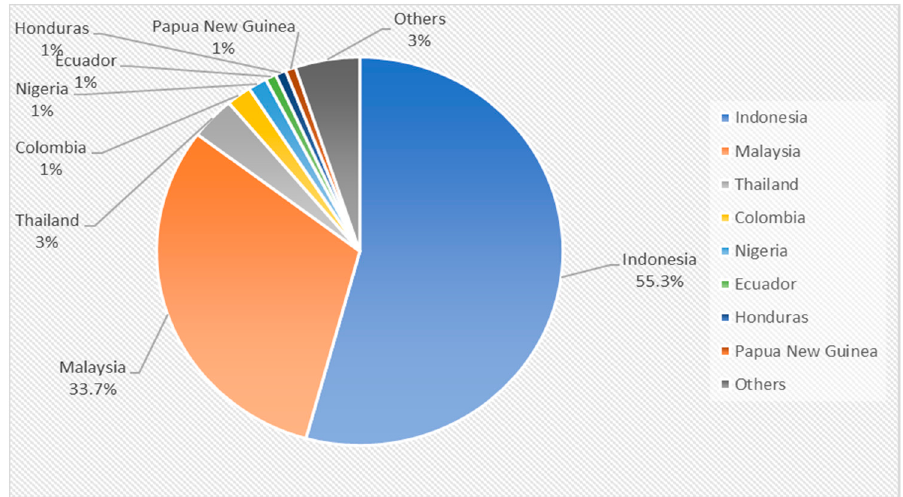
Figure 2. Overall palm oil production by country in 2019 [13].